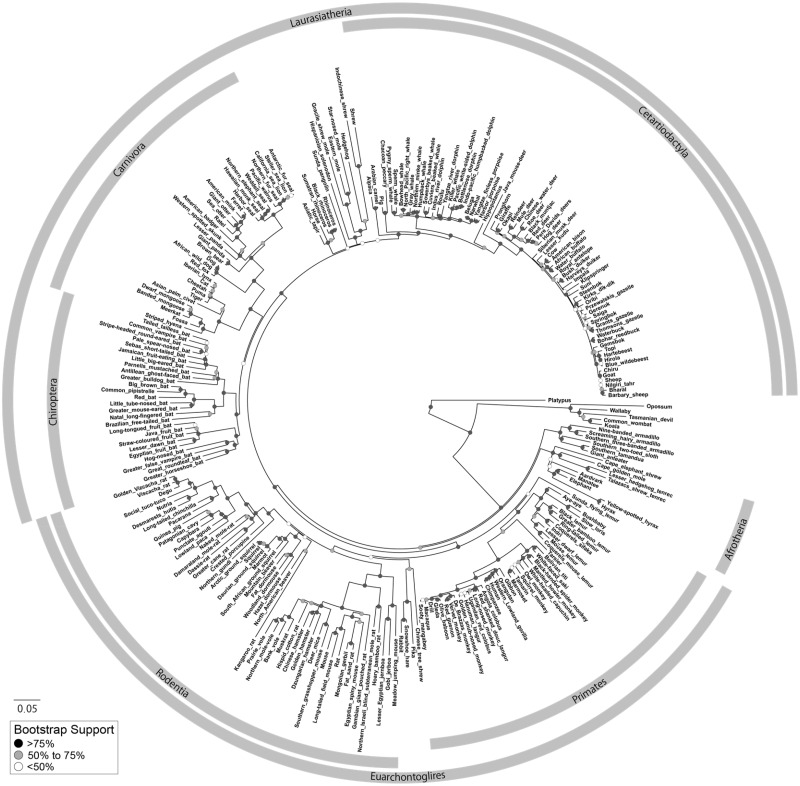
—The maximum likelihood tree of ancV1R gene tree for 261 mammals. Gray rectangles indicate members of major orders and superorders. Colored circles on each node indicate bootstrap values described in the legend. Scale bar indicates the number of nucleotide substitutions/site. The phylogenetic tree including all bony vertebrates is shown in the supplementary figure S1, Supplementary Material online.